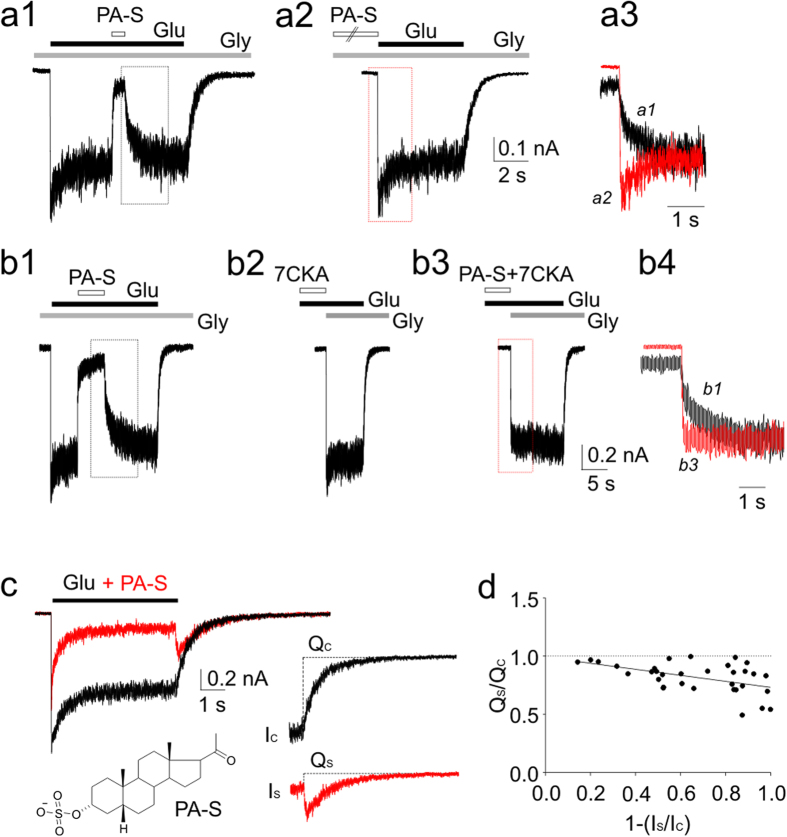
Neurosteroid-induced inhibition is use-dependent.(a1) Current response of GluN1/GluN2B receptors to glutamate (1 mM) (in the presence of 10 μM glycine) was inhibited by PA-S (150 μM) with slow off kinetics (left). (a2) The onset of the response to glutamate was not affected by 5 s pre-application of PA-S in the presence of 10 μM glycine (middle). (a3) The off responses to PA-S washout following its application in the presence of glutamate and glycine (black trace; dotted box in a1) and of glycine only (red trace; dotted box in a2) are shown overlaid. (b1) Control response to PA-S made in the presence of glutamate and glycine. (b2) Response to glutamate (1 mM) and glycine (30 μM) made following glutamate (1 mM) and 7-CKA (100 μM) co-application in the absence of added glycine. (b3) Response to glycine and glutamate made following PA-S pre-application for 5 s in the presence of glutamate, 7-CKA, and absence of added glycine. (b4) The off responses to PA-S washout following its application in the presence of glutamate and glycine (black trace; dotted box in b1) and glutamate, 7-CKA, and absence of added glycine (red trace; dotted box in b3) are shown overlaid. (c) Superposition of a control response to glutamate (1 mM) (black) and glutamate response made in the presence of PA-S (100 μM) (red). Inset shows the structure of PA-S. (d) Graph of the control-normalized charge transfer during the after-current (Qs/Qc) and the extent of the stationary current inhibition (1–(IS/IC)). The after-current was recorded after glutamate and PA-S (10, 30, 50, 100, 150, 300 μM) co-application. Data were fitted with linear regression with a slope of –0.26 (n = 7).